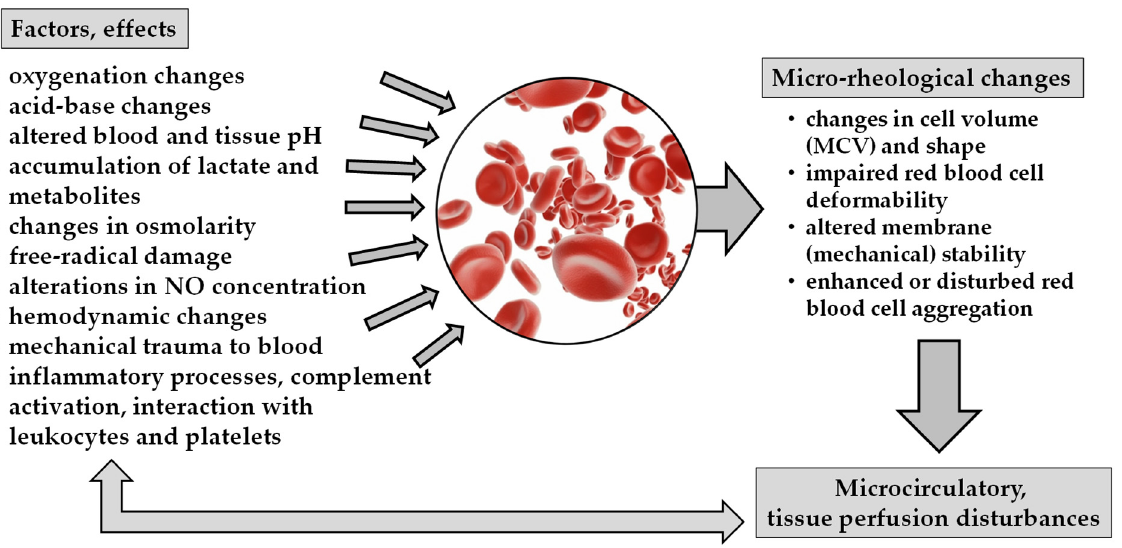
Figure 1. Schematic overview of factors and effects causing micro-rheological changes and their consequences on microcirculation.